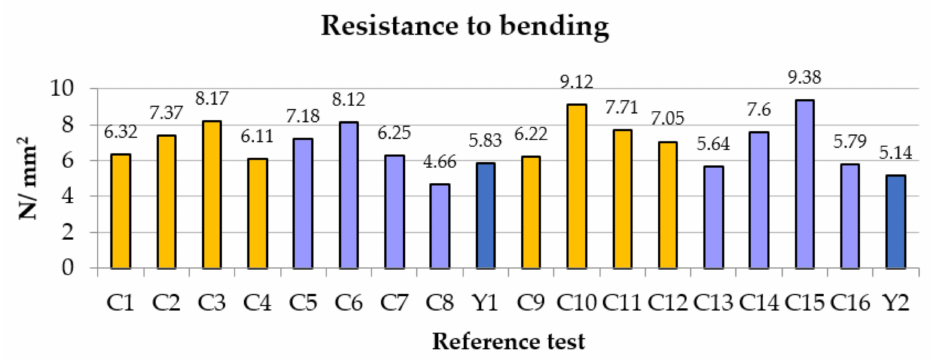
Figure 4. Comparative bending